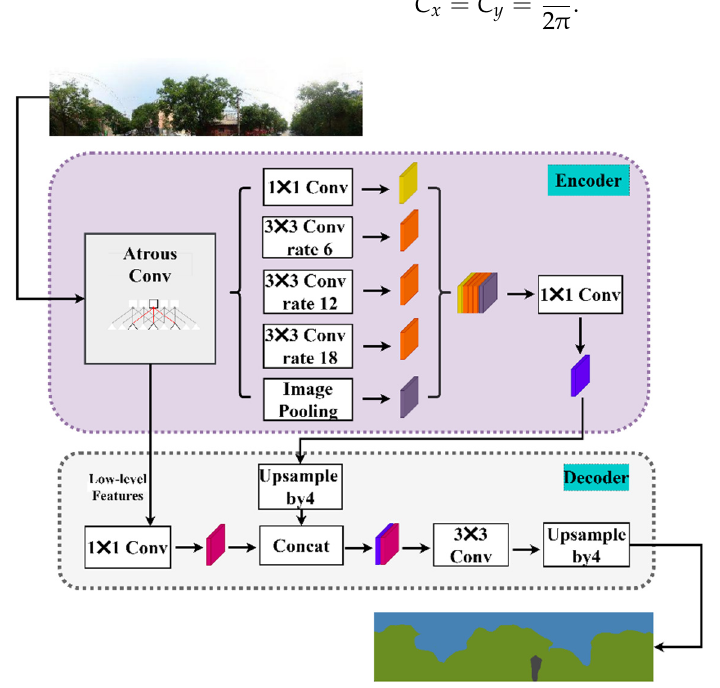
Figure 3. DeepLabv3+ semantic segmentation network structure.